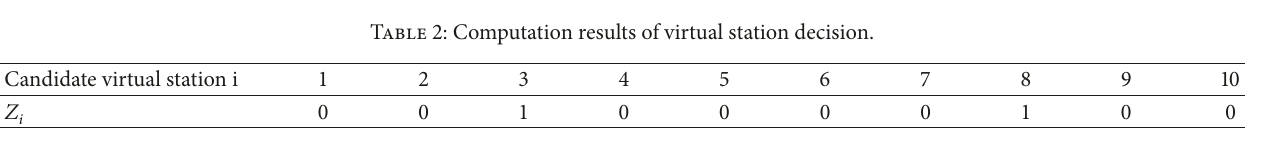
Table 3: Performance analysis of CPLEX and the clustering algorithm. K =